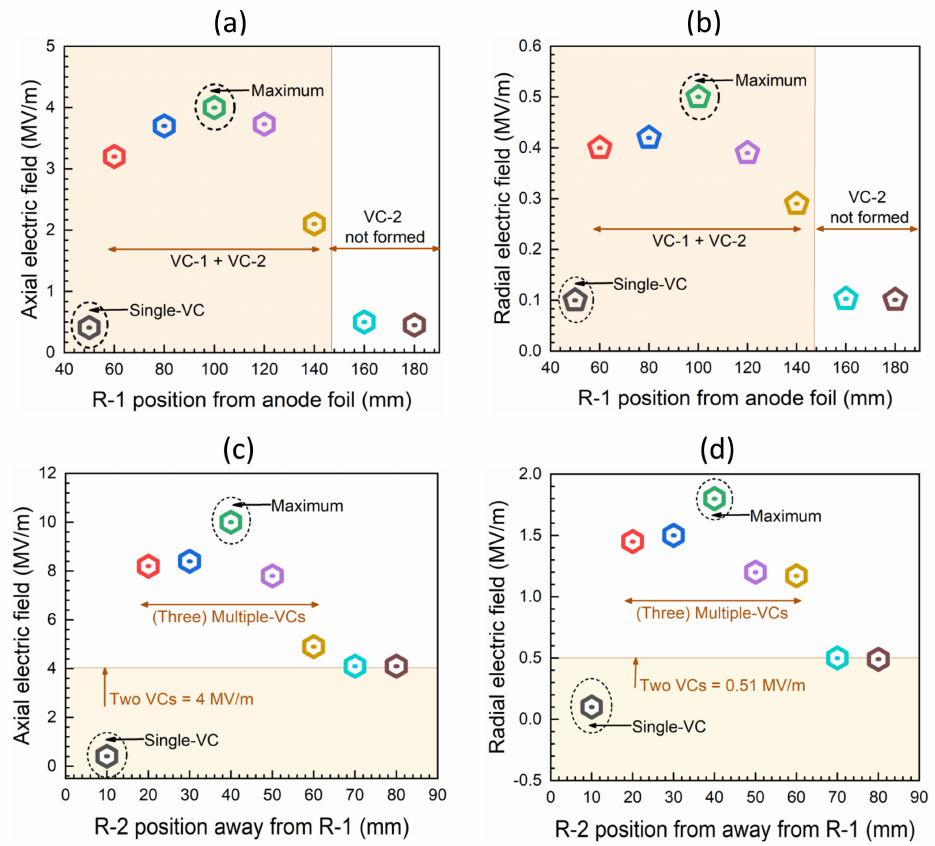
Figure 5. The effect of multiple VCs on the electric field, where ( a , b ) indicates the amplitude of the AEF and REF by changing the position of R-1 and forming VC-2. Similarly, ( c , d ) shows the maximum amplitude of AEF and REF with three or multiple VCs by changing the position of